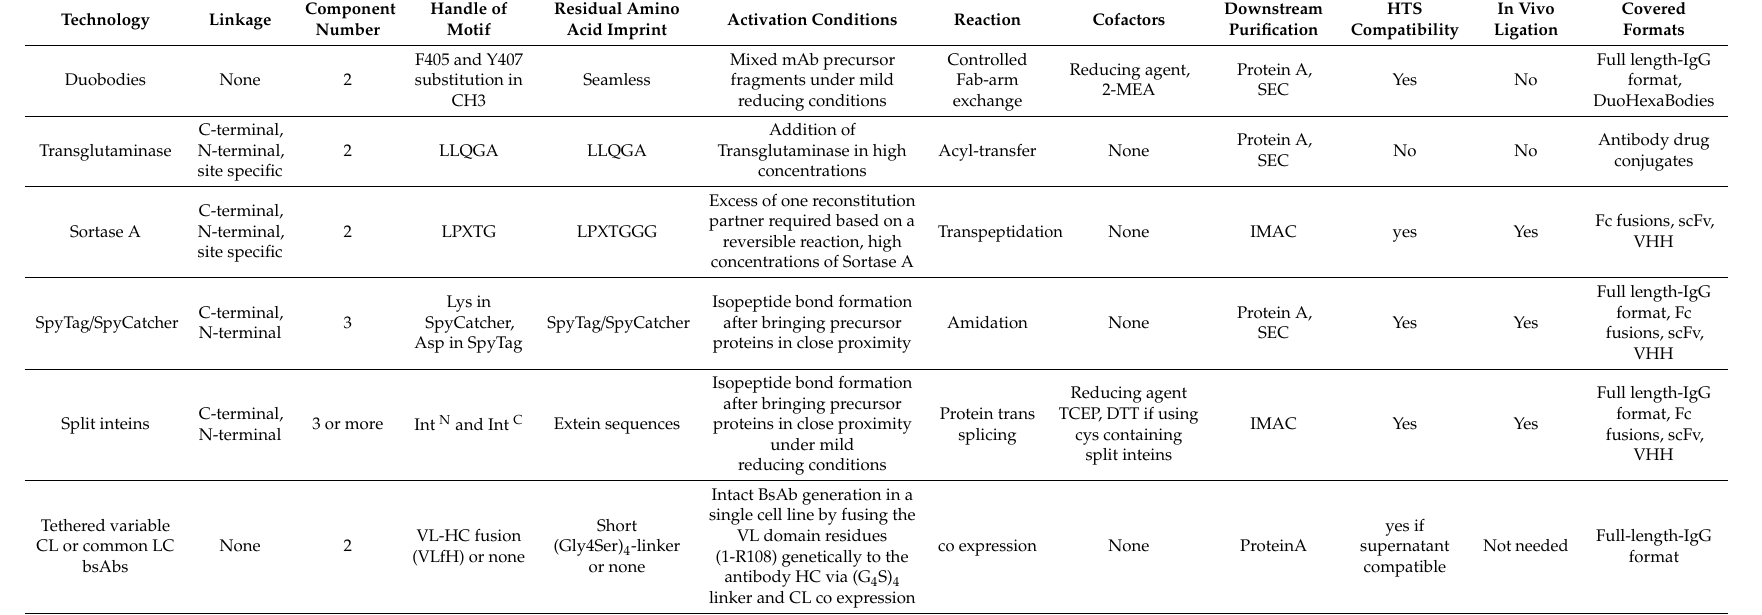
Table 1. Comparison between di ff erent bioconjugation technologies for posttranslational antibody modification. The technologies presented here are able to reconstitute antibody fragments in vitro on the protein level. Tethered variable CL as well as common LC bsAbs are generated on a molecular biology basis and not recombined on the protein